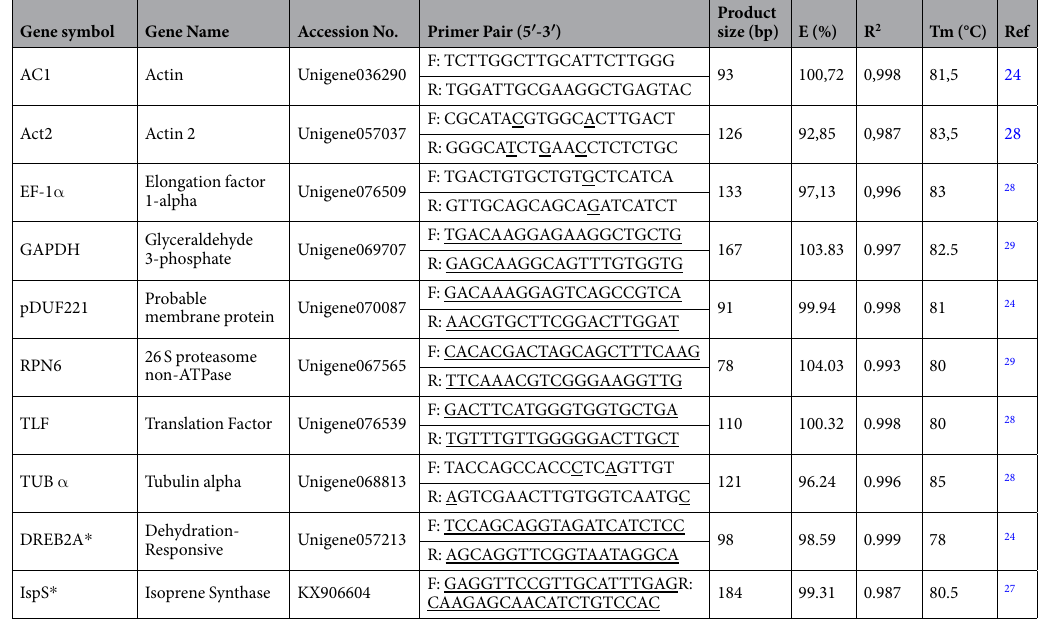
Table 1. Summary of the eight candidate reference genes tested and two A. donax target genes used for their validation. Sequence and amplicon characteristics are provided for each primer pair. Underlined primers/bases are specifically designed for A. donax . E (%) is primer efficiency calculated with standard curves and formula E = 10 ( − 1/slope) * 100; R 2 is the correlation coefficient; Tm is the melting curve temperature. Asterisc ( * ) indicates the target genes used for reference gene validation.